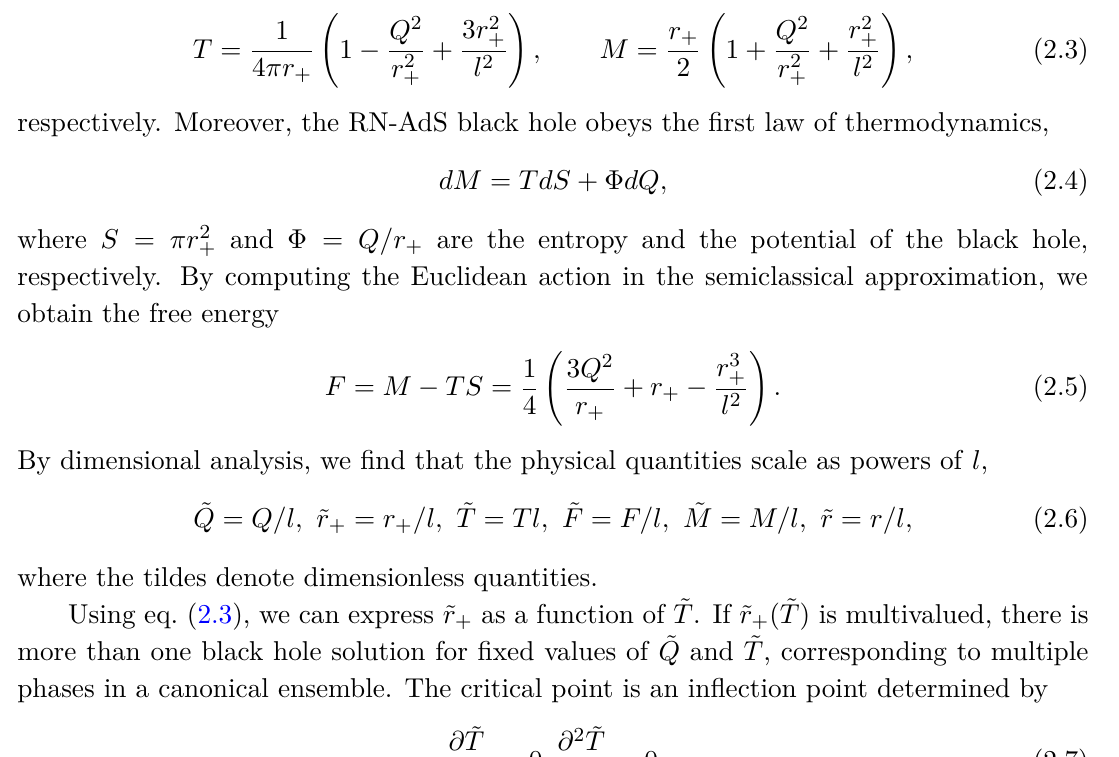
Figure 1 . Free energy ˜ F as a function of the temperature ˜ T for RN-AdS black holes. Left: ˜ Q = 0 . 11 < ˜ Q c . There coexist three black hole solutions when transition between Small BH and Large BH occurs at ˜ T p . Right: ˜ Q = 0 . 20 > ˜ Q c . Only one black hole solution exists, and hence no phase transition